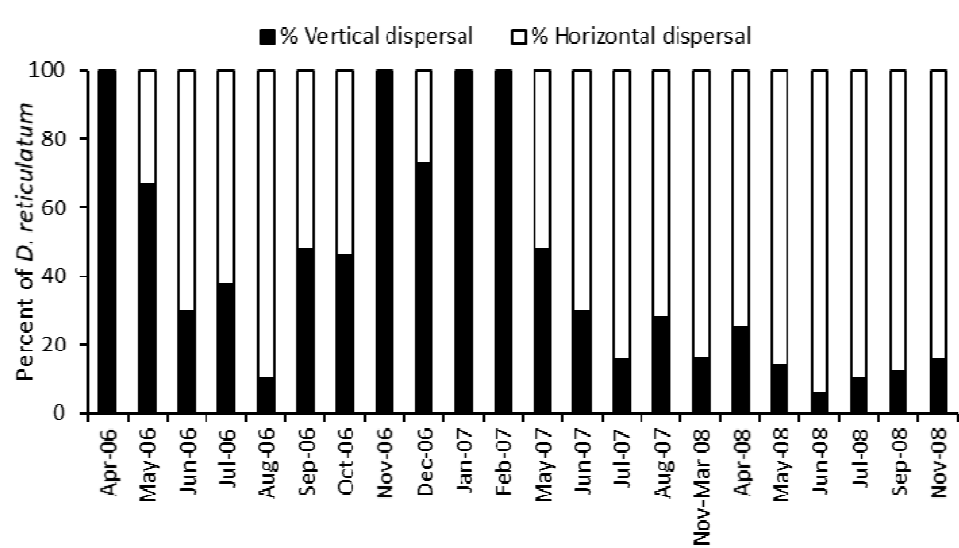
Figure 6. The percentage of Deroceras reticulatum invading vertically and horizontally estimated in each sampling period (see text).